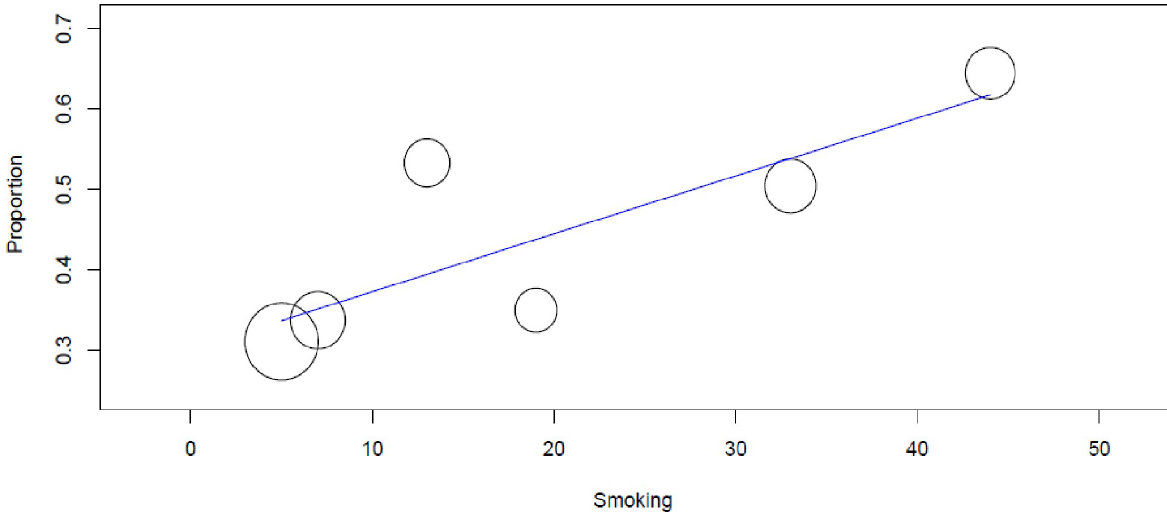
Fig 3. Regression plot of rate of uncontrolled asthma against